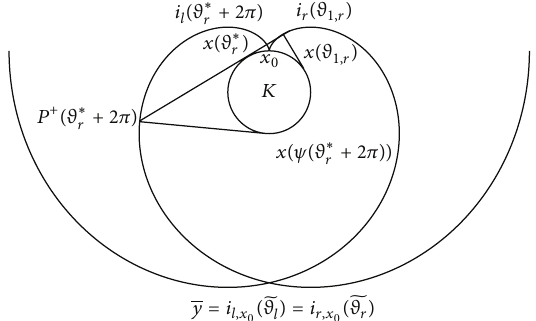
Figure 3: Involutes of a